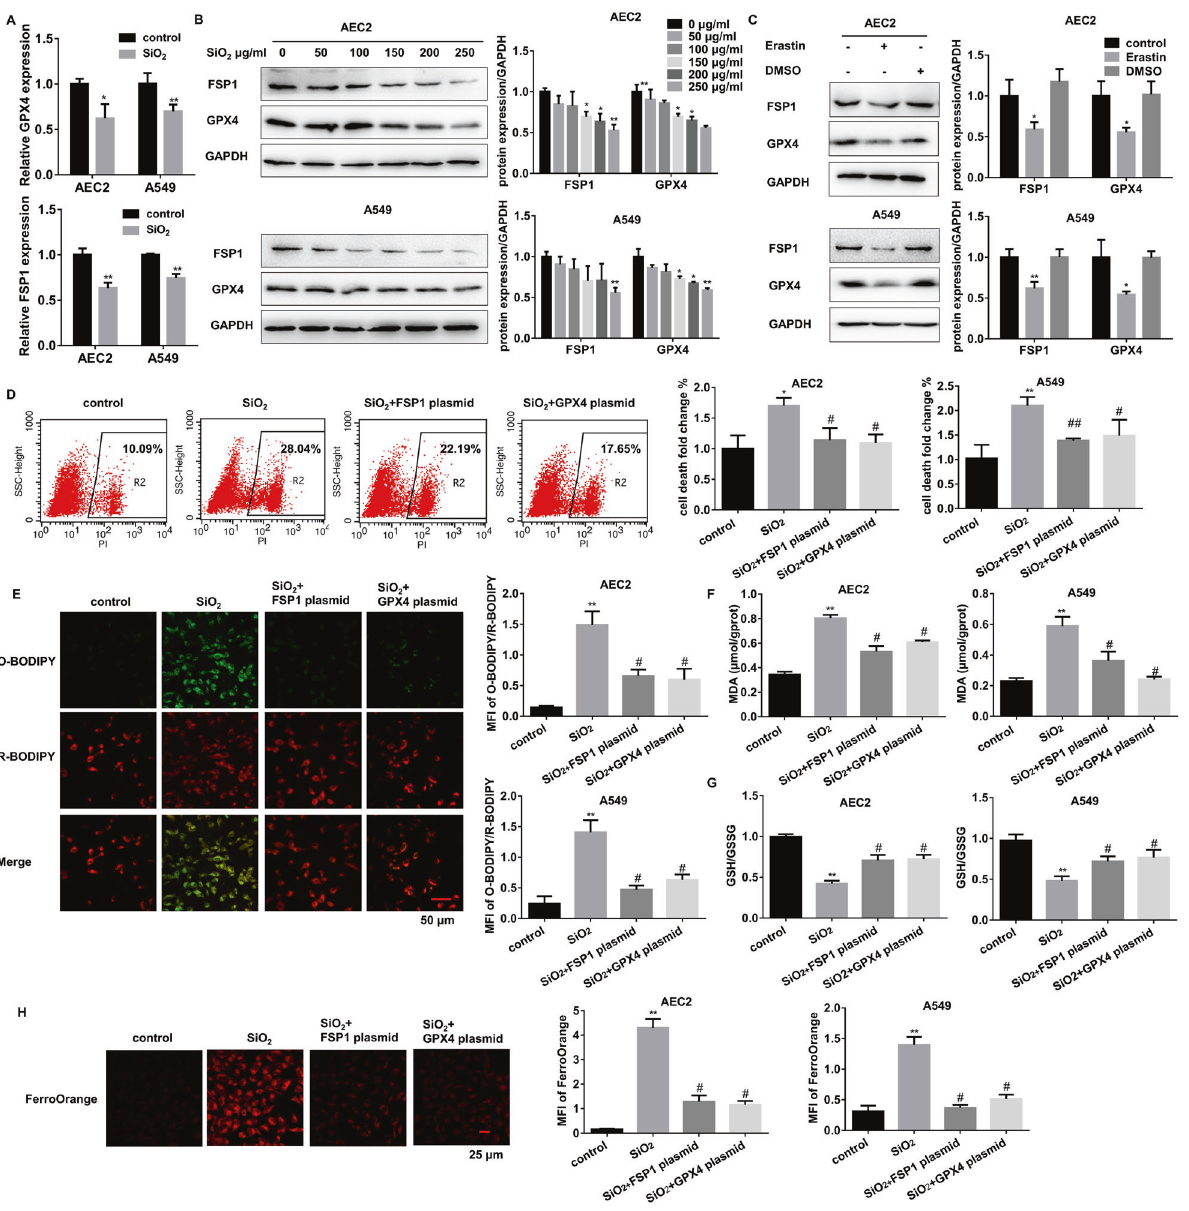
Fig. 3 GPX4 cooperates with FSP1 to regulate SiO 2 -induced AEC2 ferroptosis. A mRNA levels of GPX4 and FSP1 were measured in 150 µg/ mL SiO 2 treated primary AEC and 250 µg/mL SiO 2 treated A549 cells (* P < 0.05 versus control group, ** P < 0.01 versus control group). B Representative immunoblotting of GPX4 and FSP1 in 0, 50, 100, 150, 200, and 250 µg/mL SiO 2 treated primary AEC 2 and A549 cells (left panel), means ± SEM of three independent experiments (right) are shown. C Mouse primary AEC2 and A549 cells were treated with 1 μ M erastin or DMSO, representative immunoblotting of GPX4 and FSP1 (left), as well as means ± SEM of three independent experiments (right) are shown. Then AEC2 and A549 cells were treated with 150 or 250 µg/mL SiO 2 individually, SiO 2 with FSP1 plasmid, and SiO 2 with GPX4 plasmid. D Flow cytometry representative pictures of primary AEC2 and quanti fi cation results of both primary AEC2 and A549 cells. E Representative images of C11-BODIPY in treated-primary AEC cells ( red : reduced C11-BODIPY, green: oxidized C11-BODIPY; scale bars, 50 µm; left panel), and quanti fi cation of C11-BODIPY fl uorescence in primary AEC2 and A549 cells (right panel). F MDA concentration in cell lysates from primary AEC2 and A549 cells was measured using a Lipid Peroxidation MDA Assay Kit. G GSH/GSSG ratio of primary AEC2 and A549 cells. H Intracellular Fe 2 + was detected with the FerroOrange probe, and representative images of primary AEC2 cells were shown ( red : FerroOrange-stained Fe 2 + ; scale bars, 25 µm; left panel). Fe 2 + fl uorescence intensity was quanti fi ed by ImageJ in both primary AEC2 and A549 cells (right panel). ** P < 0.01 versus control group, # P < 0.01 versus SiO 2 -treated